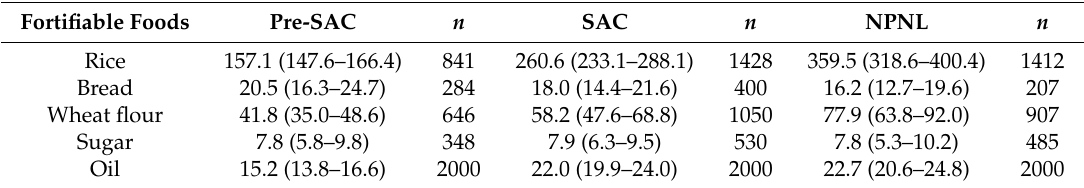
Table 4. Mean (95% CI) consumption of rice, bread, wheat flour, sugar, and oil by consuming population groups